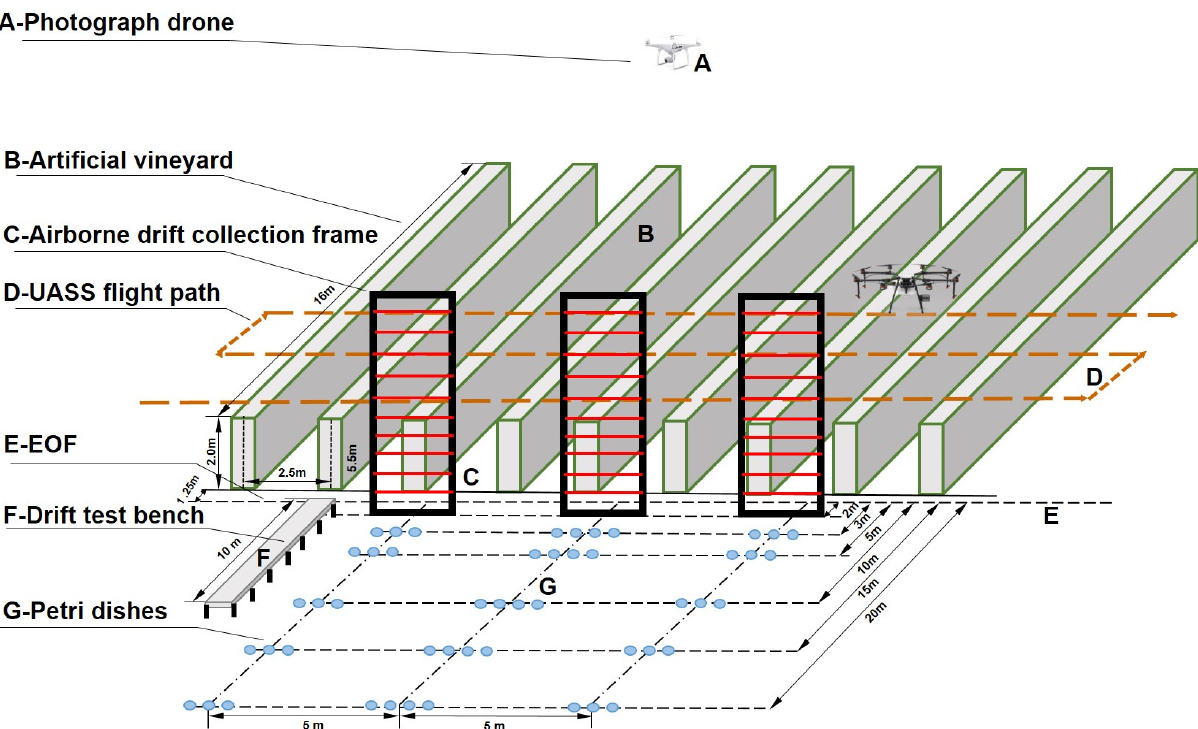
Figure 3. UASS spray drift measurement arrangement using three types of collectors: test bench, ground petri dish and airborne collection frame, and an artificial vineyard [30].